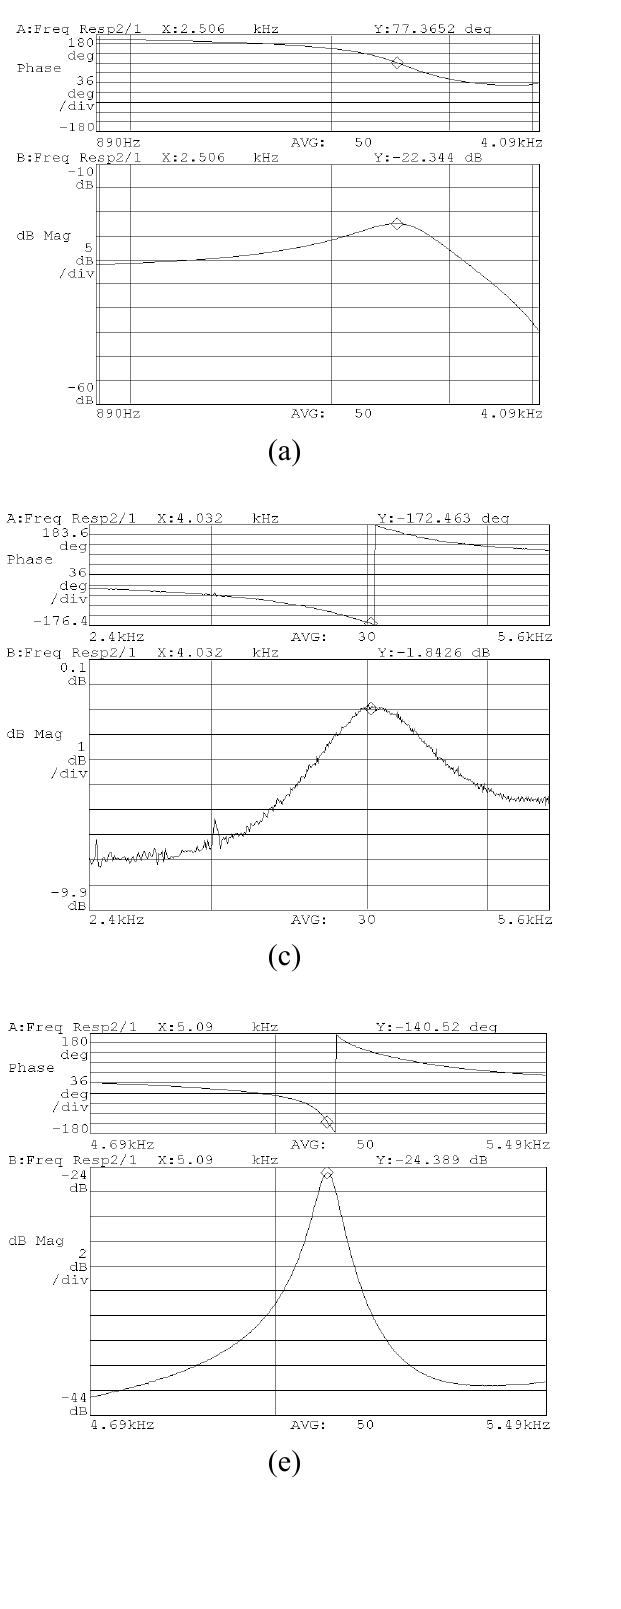
Figure 15. The frequency responses of the six inertial sensors. (a) X/Y-axis accelerometer; (b) Z-axis accelerometer; (c) X/Y-axis gyroscope in drive mode; (d) X/Y-axis gyroscope in sense mode; (e) Z-axis gyroscope in drive mode; (f) Z-axis gyroscope in sense